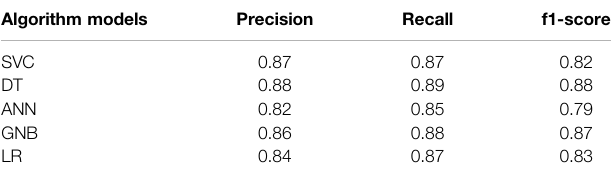
TABLE 2 | Comparison of fi ve algorithm models. Algorithm